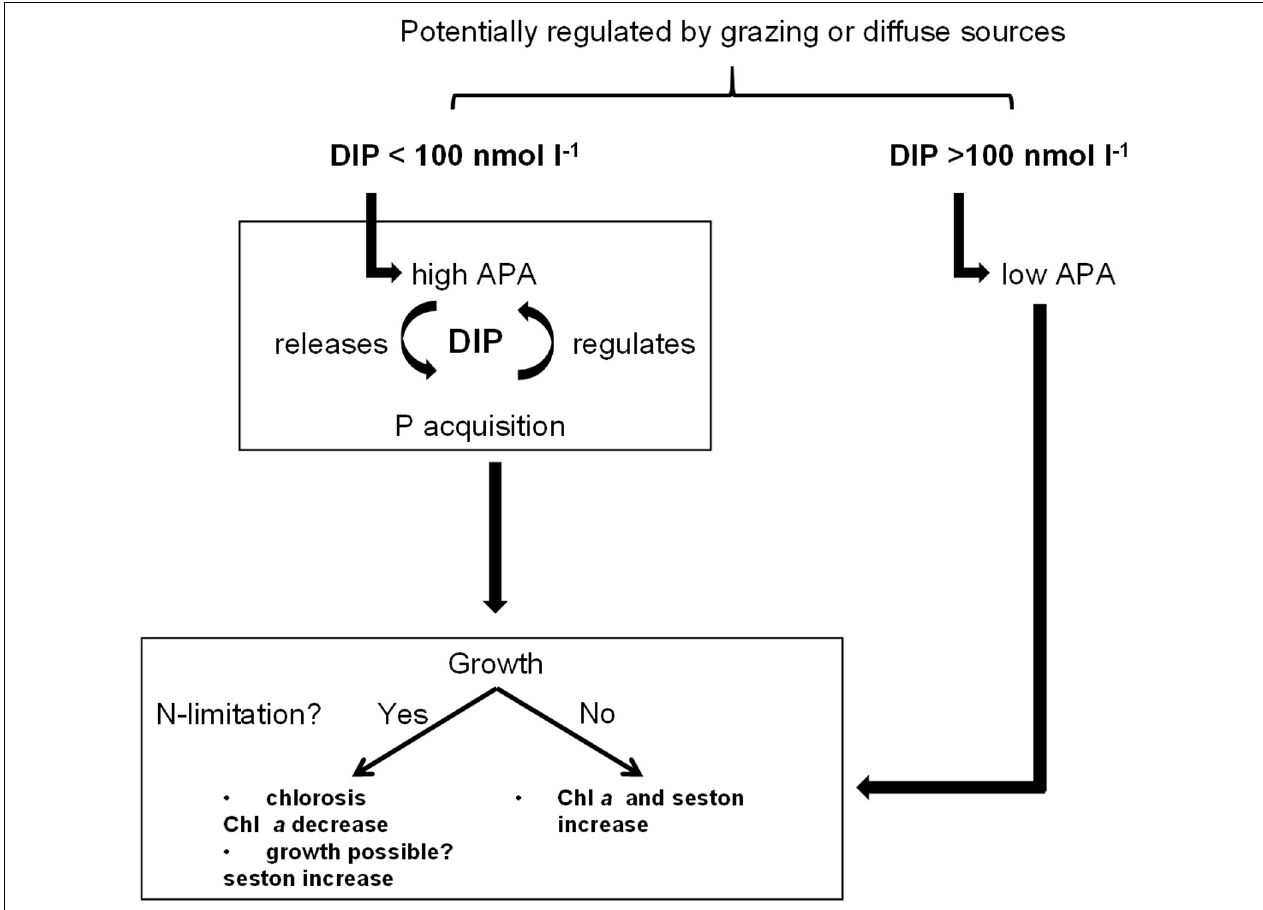
FIGURE 8 | Graphical summary of phosphate (DIP) regulation and subsequently following physiological acclimatization of phytoplankton to different available DIP concentrations.